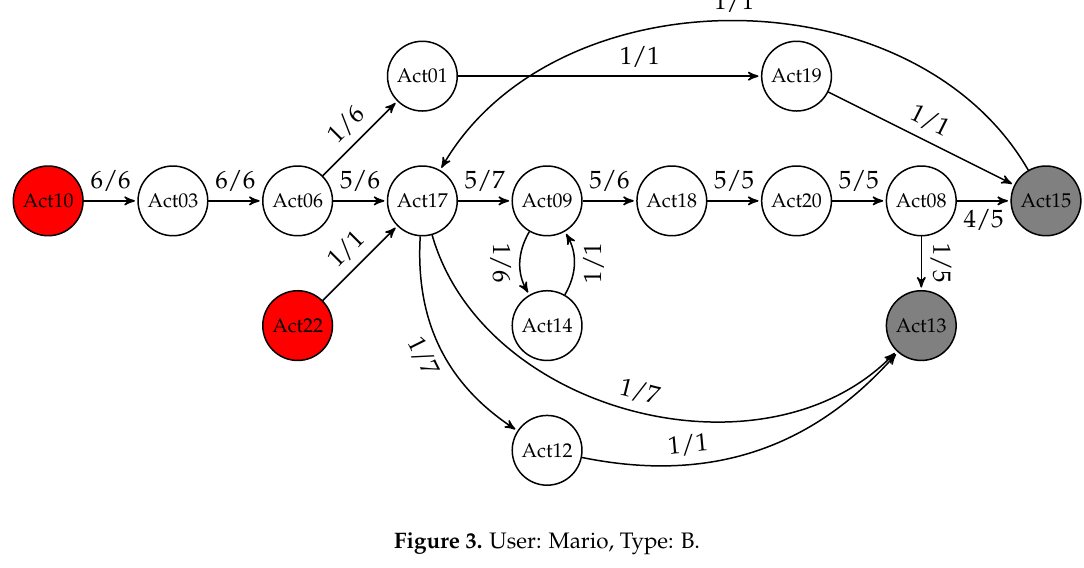
Figure 3. User: Mario, Type: B.